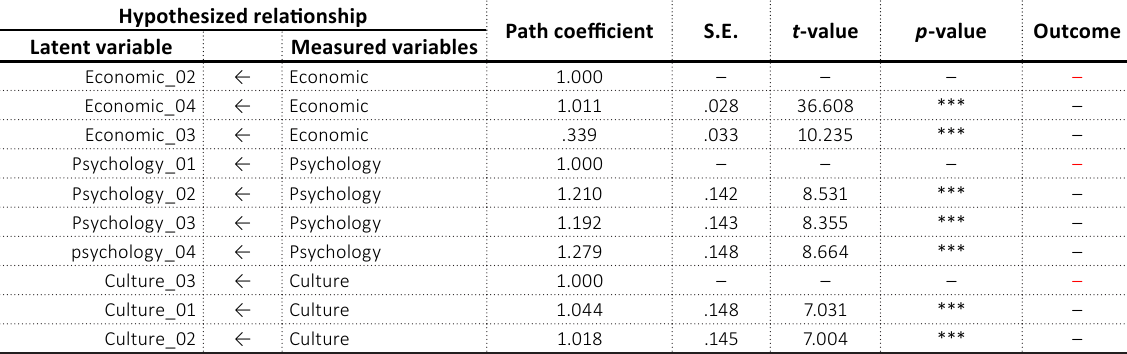
Table 4 (cont.). Model parameter maximum likelihood estimates Hypothesized relationship